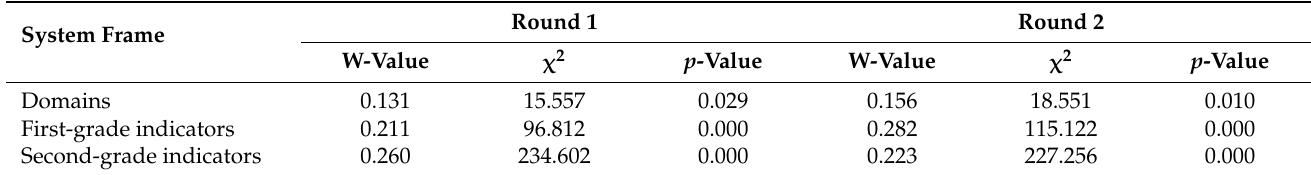
Table 3. Result of expert opinion coordination degree.